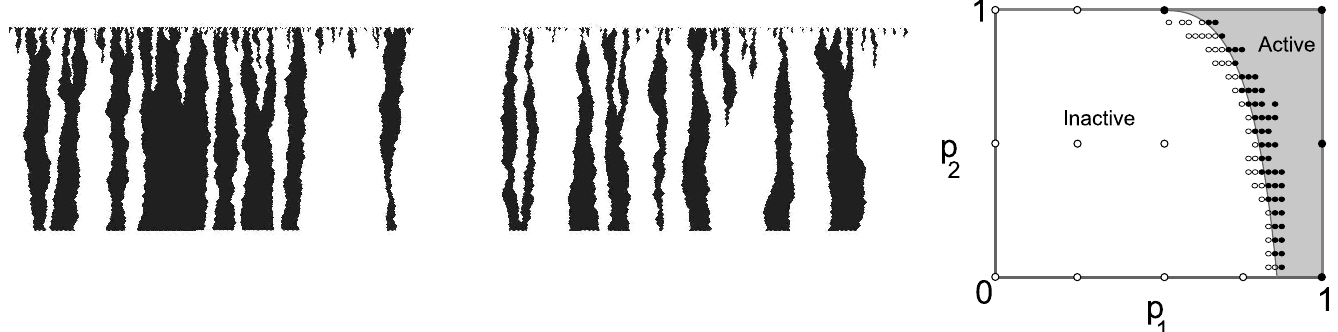
Fig 8. DKCA patterns generated from the same seed can be wildly different (Left/Center). The DKCA phase diagram (Right) describes the observable behavior of the DKCA across a spectrum of probabilities p 1 and p 2 , with typical non/percolating behavior of an ECA assembler (shown as filled/empty circles, respectively) consistent with the phase-transition DKCA behavior overall (the thresholding curve separates percolating from nonpercolating CA